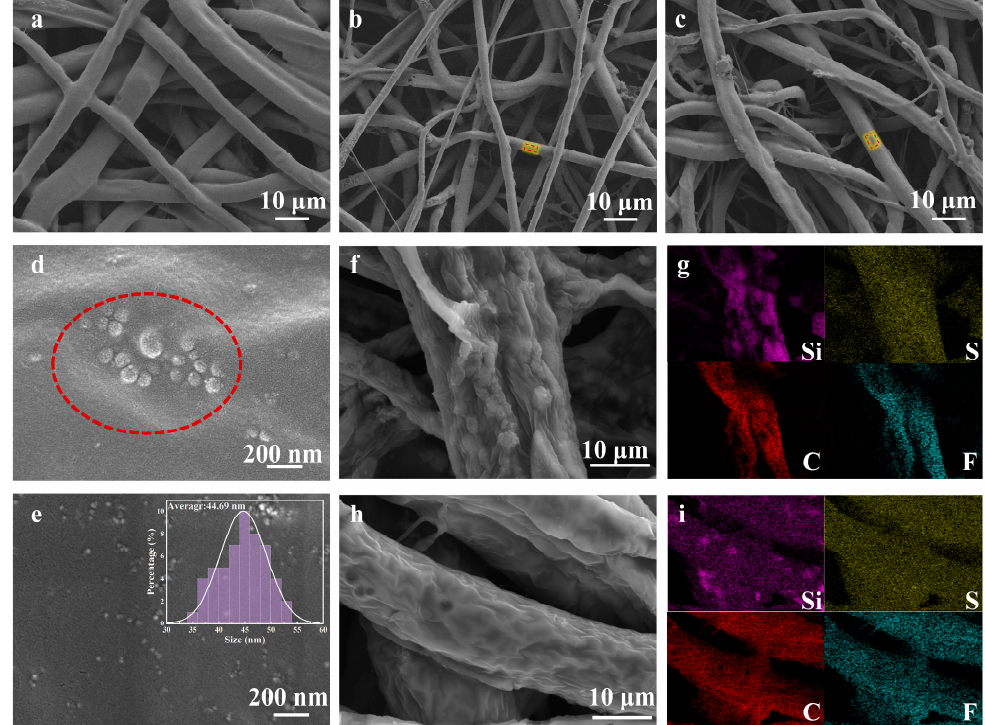
Figure 2. SEM images of as-spun SPEs with ( a ) no SiO 2 , ( b ) 45nm 10 wt% SiO 2 of mechanical doping, ( c ) 45nm 10 wt% SiO 2 of in situ formation, ( d ) the partial enlarged view in box of ( b ), and ( e ) the partial enlarged view in box of ( c ). EDS mapping of Si, C, F, and S elements in 45 nm 10 wt% SiO 2 of mechanical doping ( f , g ) and 45nm 10 wt% SiO 2 of in situ formation ( h , i ). For the abovementioned multiple conduction modes of lithium ions, all of them are based on the low crystallinity of the PEO matrix. Compared with a simple mechanical doping method, the in situ generation and re-growth technology used in this study suc- cessfully dispersed SiO 2 nanospheres uniformly into polymer hosts. At the same time, the -OH at the end of the PEO chain can also chemically bond with the -OH on the surface of SiO 2 under hydrolysis conditions. These two interaction mechanisms result in a substantial reduction in the crystallinity of the PEO matrix by disturbing the ordered arrangement of the macromolecular chain segments